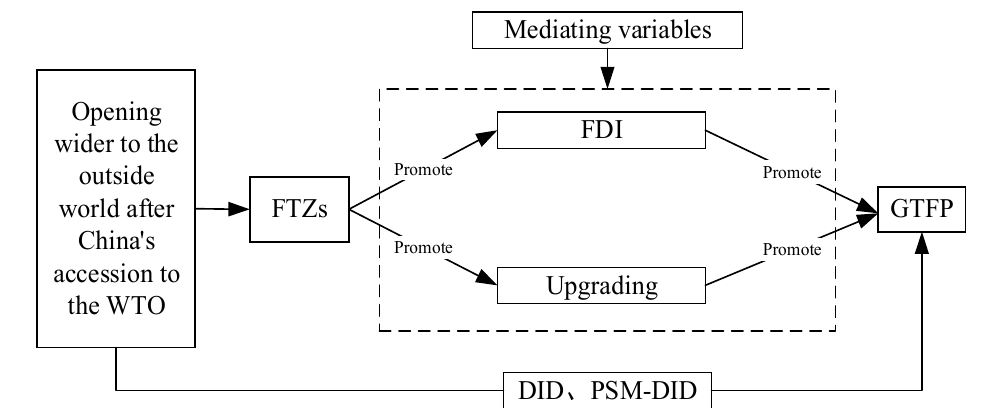
Figure 2. The framework of the influence of pilot FTZs on GTFP . Source: Compiled by the author. Hypothesis 2 (H2). Pilot FTZs can increase GTFP through the promotion of industrial upgrading